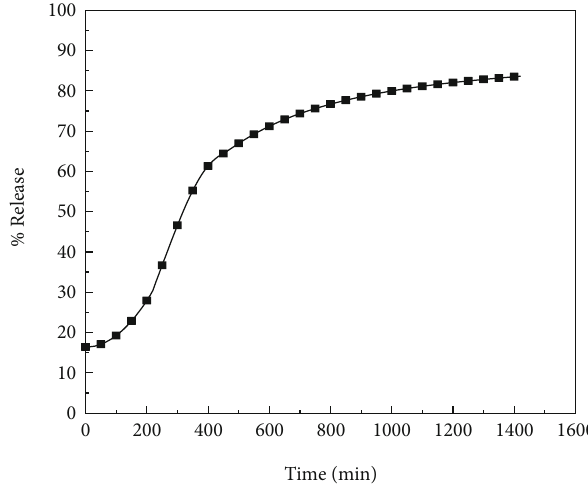
Figure 10: In vitro release of Amlodipine from Amlop-polymer nanocomposites in PBS at pH